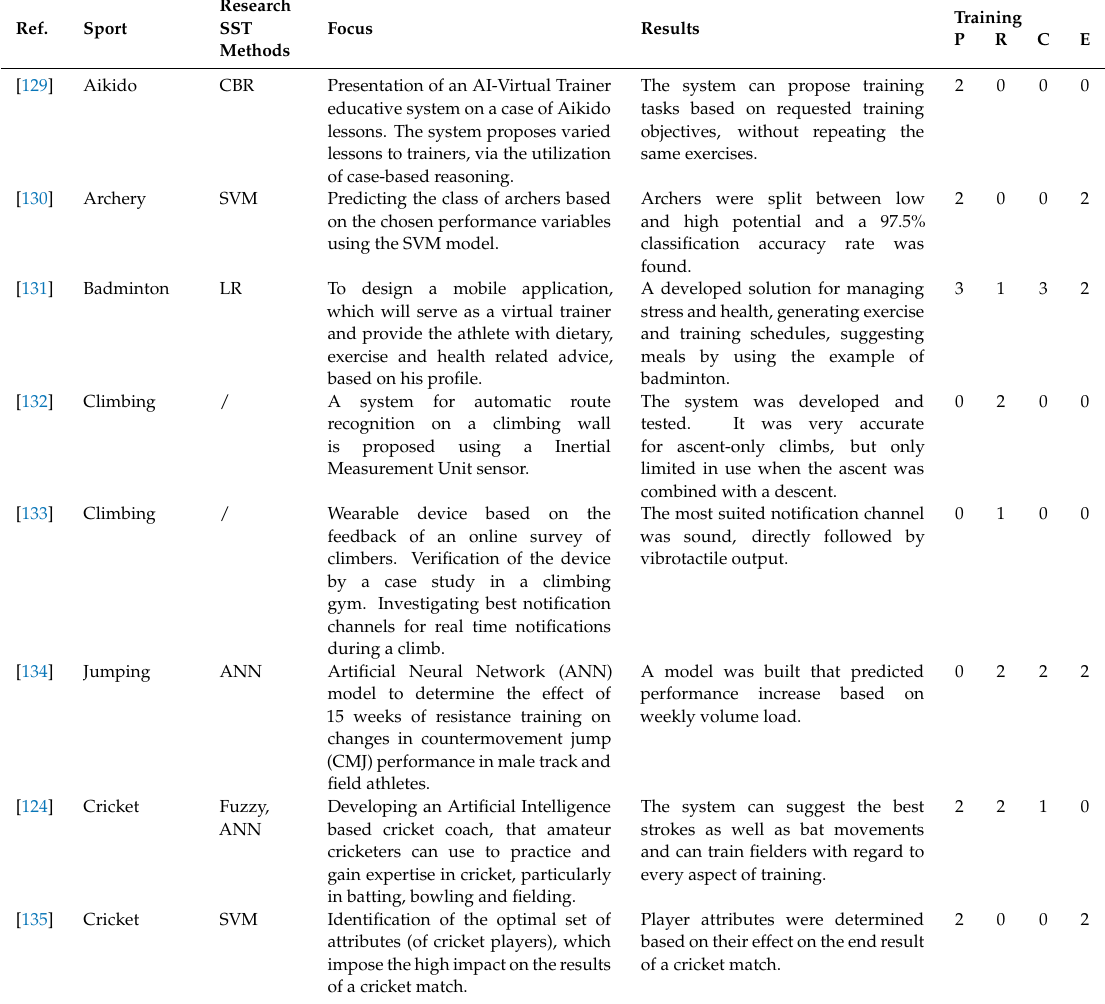
Table 18. Identified studies of other